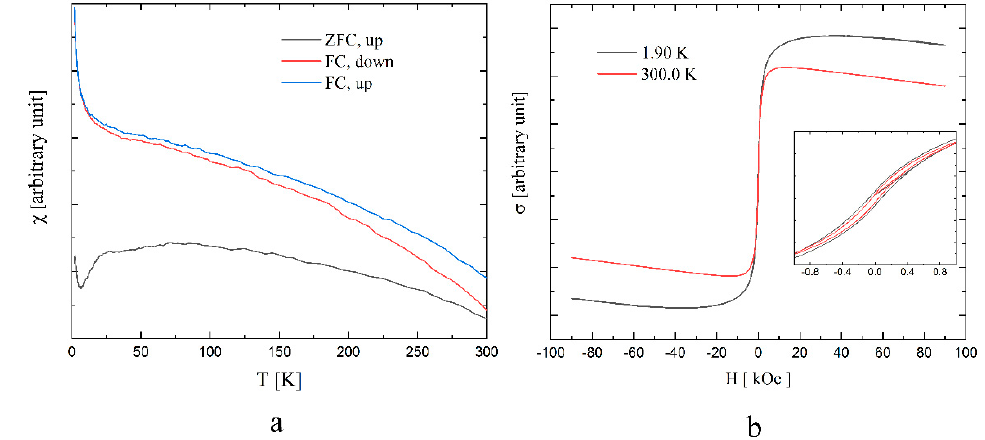
Figure 4. The dc magnetic measurements: ( a ) magnetic susceptibility at 1kOe (ZFC and FC denote zero-field cooling and field cooling regimes, respectively) and ( b ) magnetic hysteresis loops collected at 1.90 and 300.0 K (the inset presents the behavior at low magnetic fields).